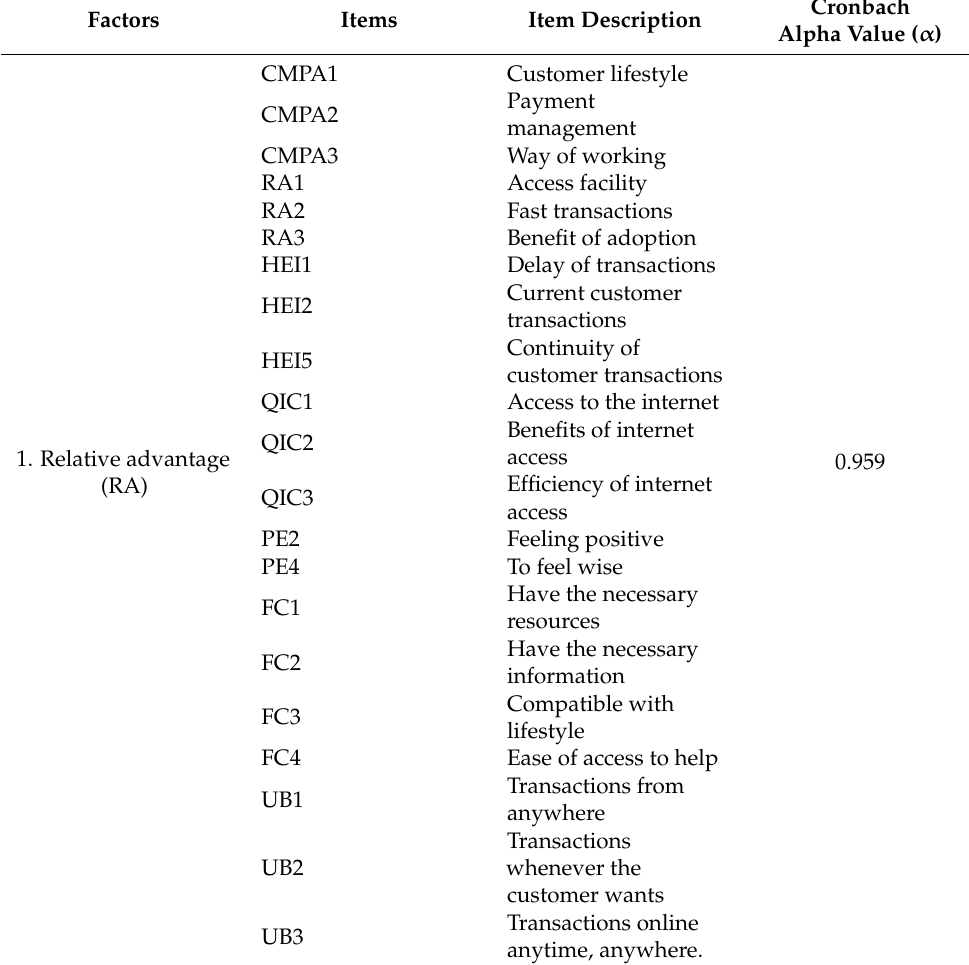
Table 6. Factors and related